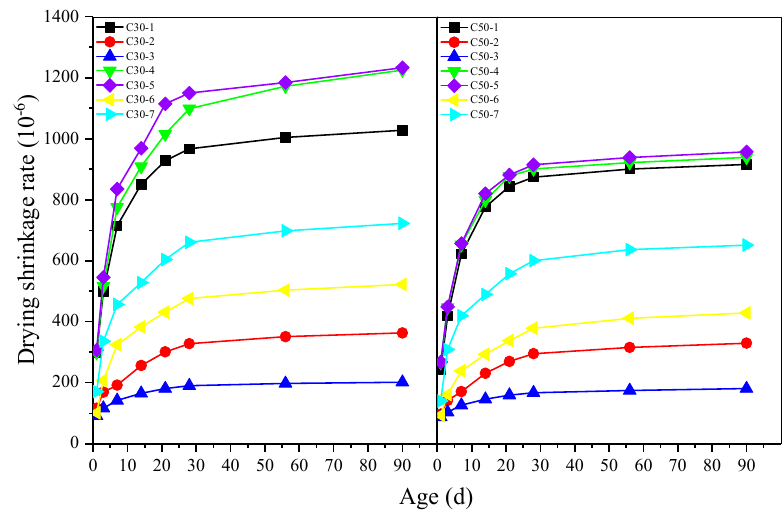
Figure 3. Effect of early age curing on drying shrinkage of AASC.